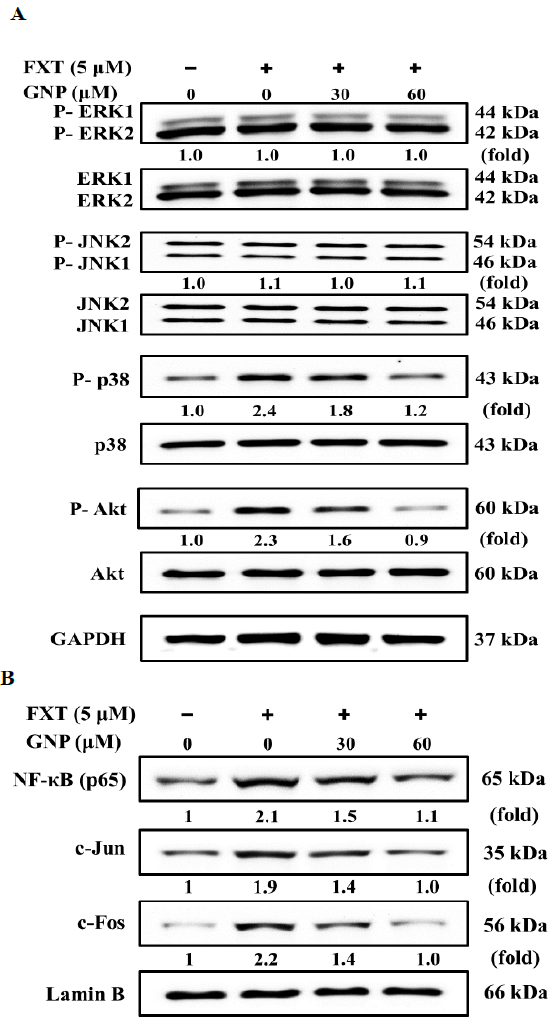
Figure 7. Western blot showing the expressions of p38 and Akt ( A ), transcription factors NF- κ B and c-Jun/c-Fos ( B ) in HepG2 cells induced by FXT and the attenuating effect of GNP. HepG2 cells were seeded onto a 6-well plate and incubated overnight, then treated with FXT and GNP at dose as indicated and further incubated for 72 h. DMSO (0.1%) was used as vehicle control for 72 h. The intensity was subsequently quantified by the densitometer.